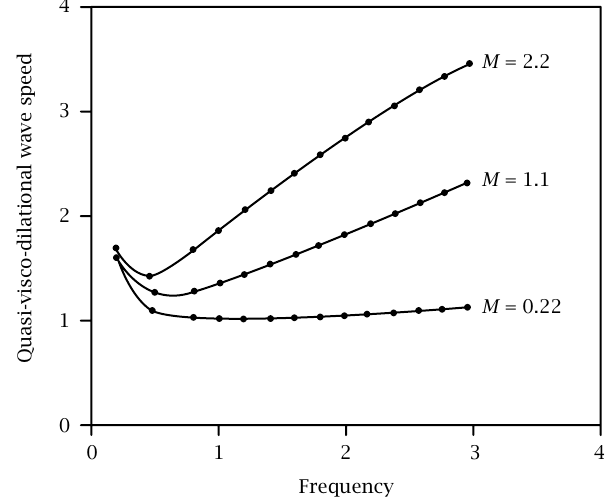
Figure 7.1 . Plot of quasi-visco-dilatational wave speed against real fre- quency ω